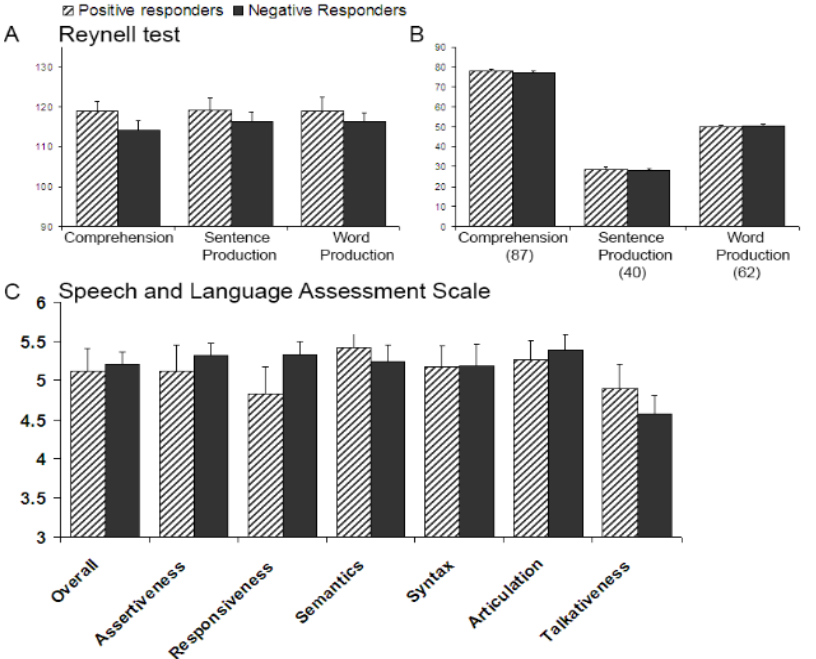
Figure 3. Language performances at five years split by group performance at 10 months; error bars are one standard error from the mean; ( A ) with standardized language quotients on the y-axis; ( B ) with raw language scores on the Y-axis (in parentheses the maximum possible score for each subtest), and ( C ) Mean parental ratings (overall and per subscale) on the speech and language assessment scale [66]. A score of “4” corresponds to parents rating their child’s language performance as equal to their child’s peers; higher scores reflect better language